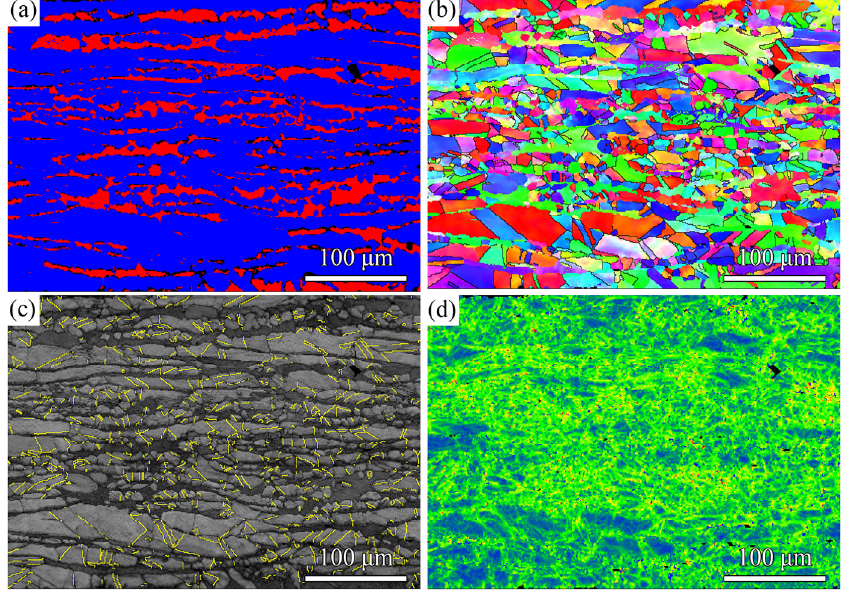
Figure 1. EBSD result of the as-received sample: ( a ) phase map; ( b ) IPF map; ( c ) band contrast map with twin boundaries; ( d ) KAM map. The yellow lines in the Panel c highlight the twin boundaries.